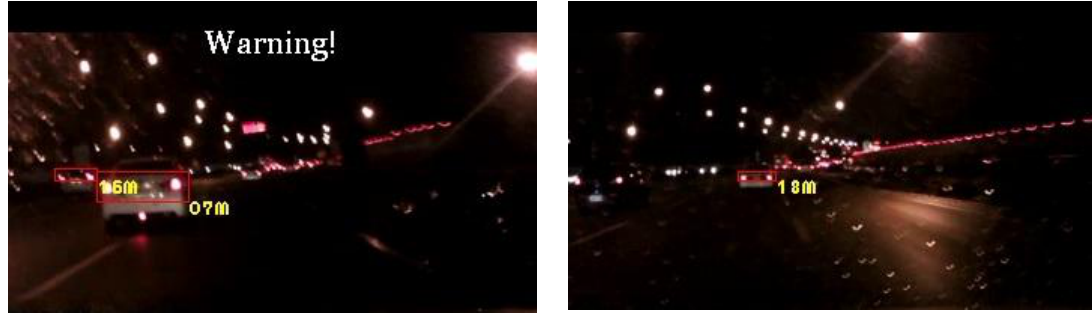
Figure 18. Results of vehicle detection and event determination for a nighttime rural road under a normal illumination with rainy and free-flowing traffic conditions (Test video 2).